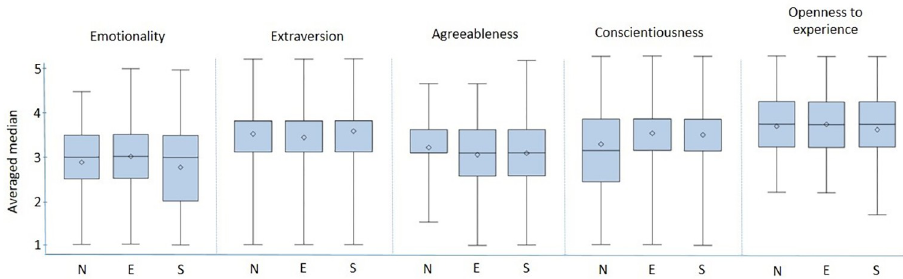
Fig 1. Distribution of median ratings per the HEXACO personality domains of dairy farmers for three different regions of Germany (n north = 181; n east = 172; n south = 226). N = north; E = east; S = south.